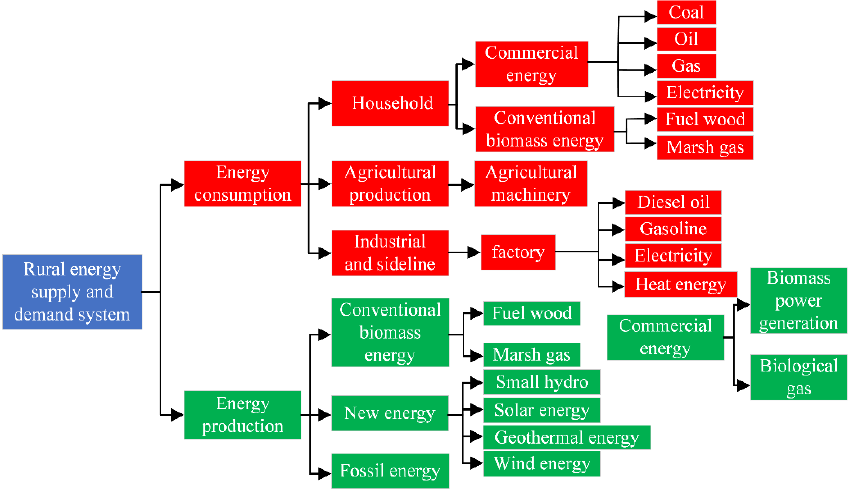
Figure 1. Rural energy supply and demand system division.